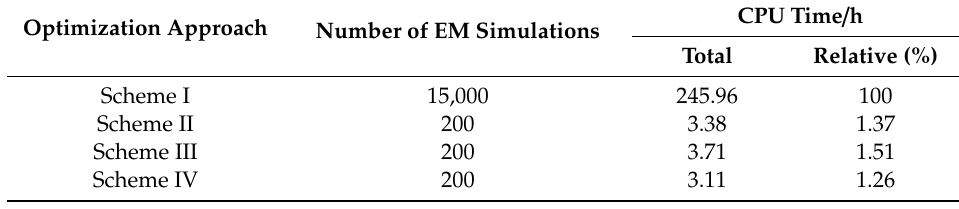
Table 6. Comparison of Computational Cost among Different Antenna Optimization Schemes.